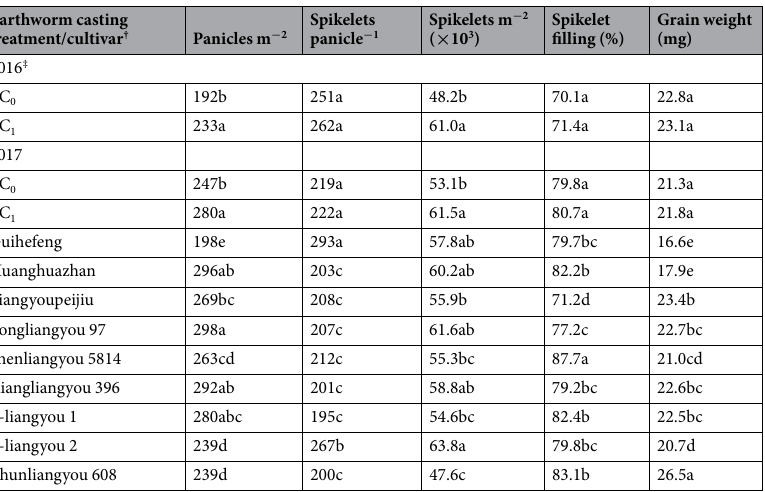
Table 2. Yield components in rice as affected by earthworm castings in 2016, and by earthworm castings and cultivars in 2017. Within a column for earthworm casting treatments in each year and for cultivars in 2017, data with the same letters are not significantly different at the 0.05 probability level (LSD test). † EC 0 and EC 1 represent absence (0 kg m − 2 ) and presence of earthworm castings (17 kg m − 2 ), respectively. ‡ Data are the means across three N rates in